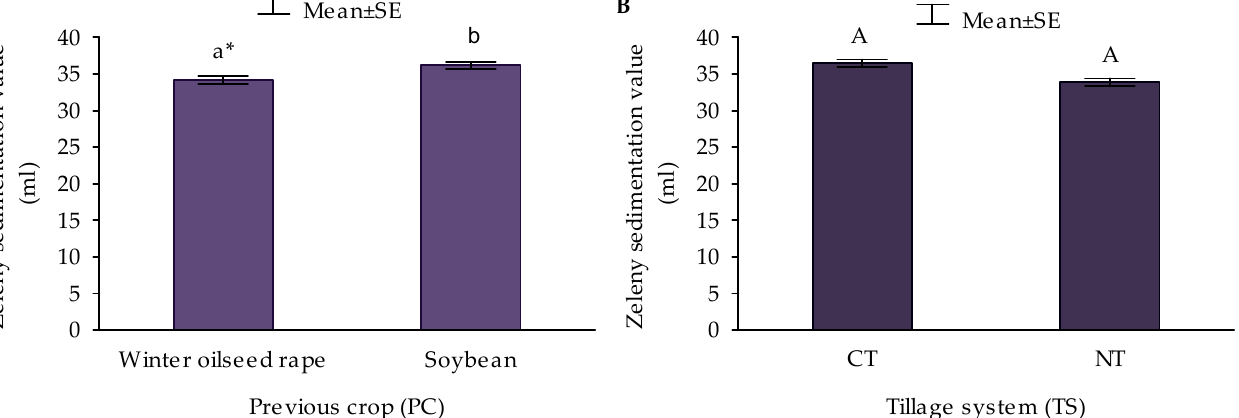
Figure 8. Zeleny sedimentation value for winter wheat grain depending on previous crop ( A ) and tillage system ( B ) (mean for 2014–2017). CT—Conventional tillage; NT—No-tillage. * Different letters denote significant differences ( p ≤ 0.05). The same letter means not significantly different values. The lowercase letters refer to previous crops (PC); the capital letters refer to tillage systems (TS).